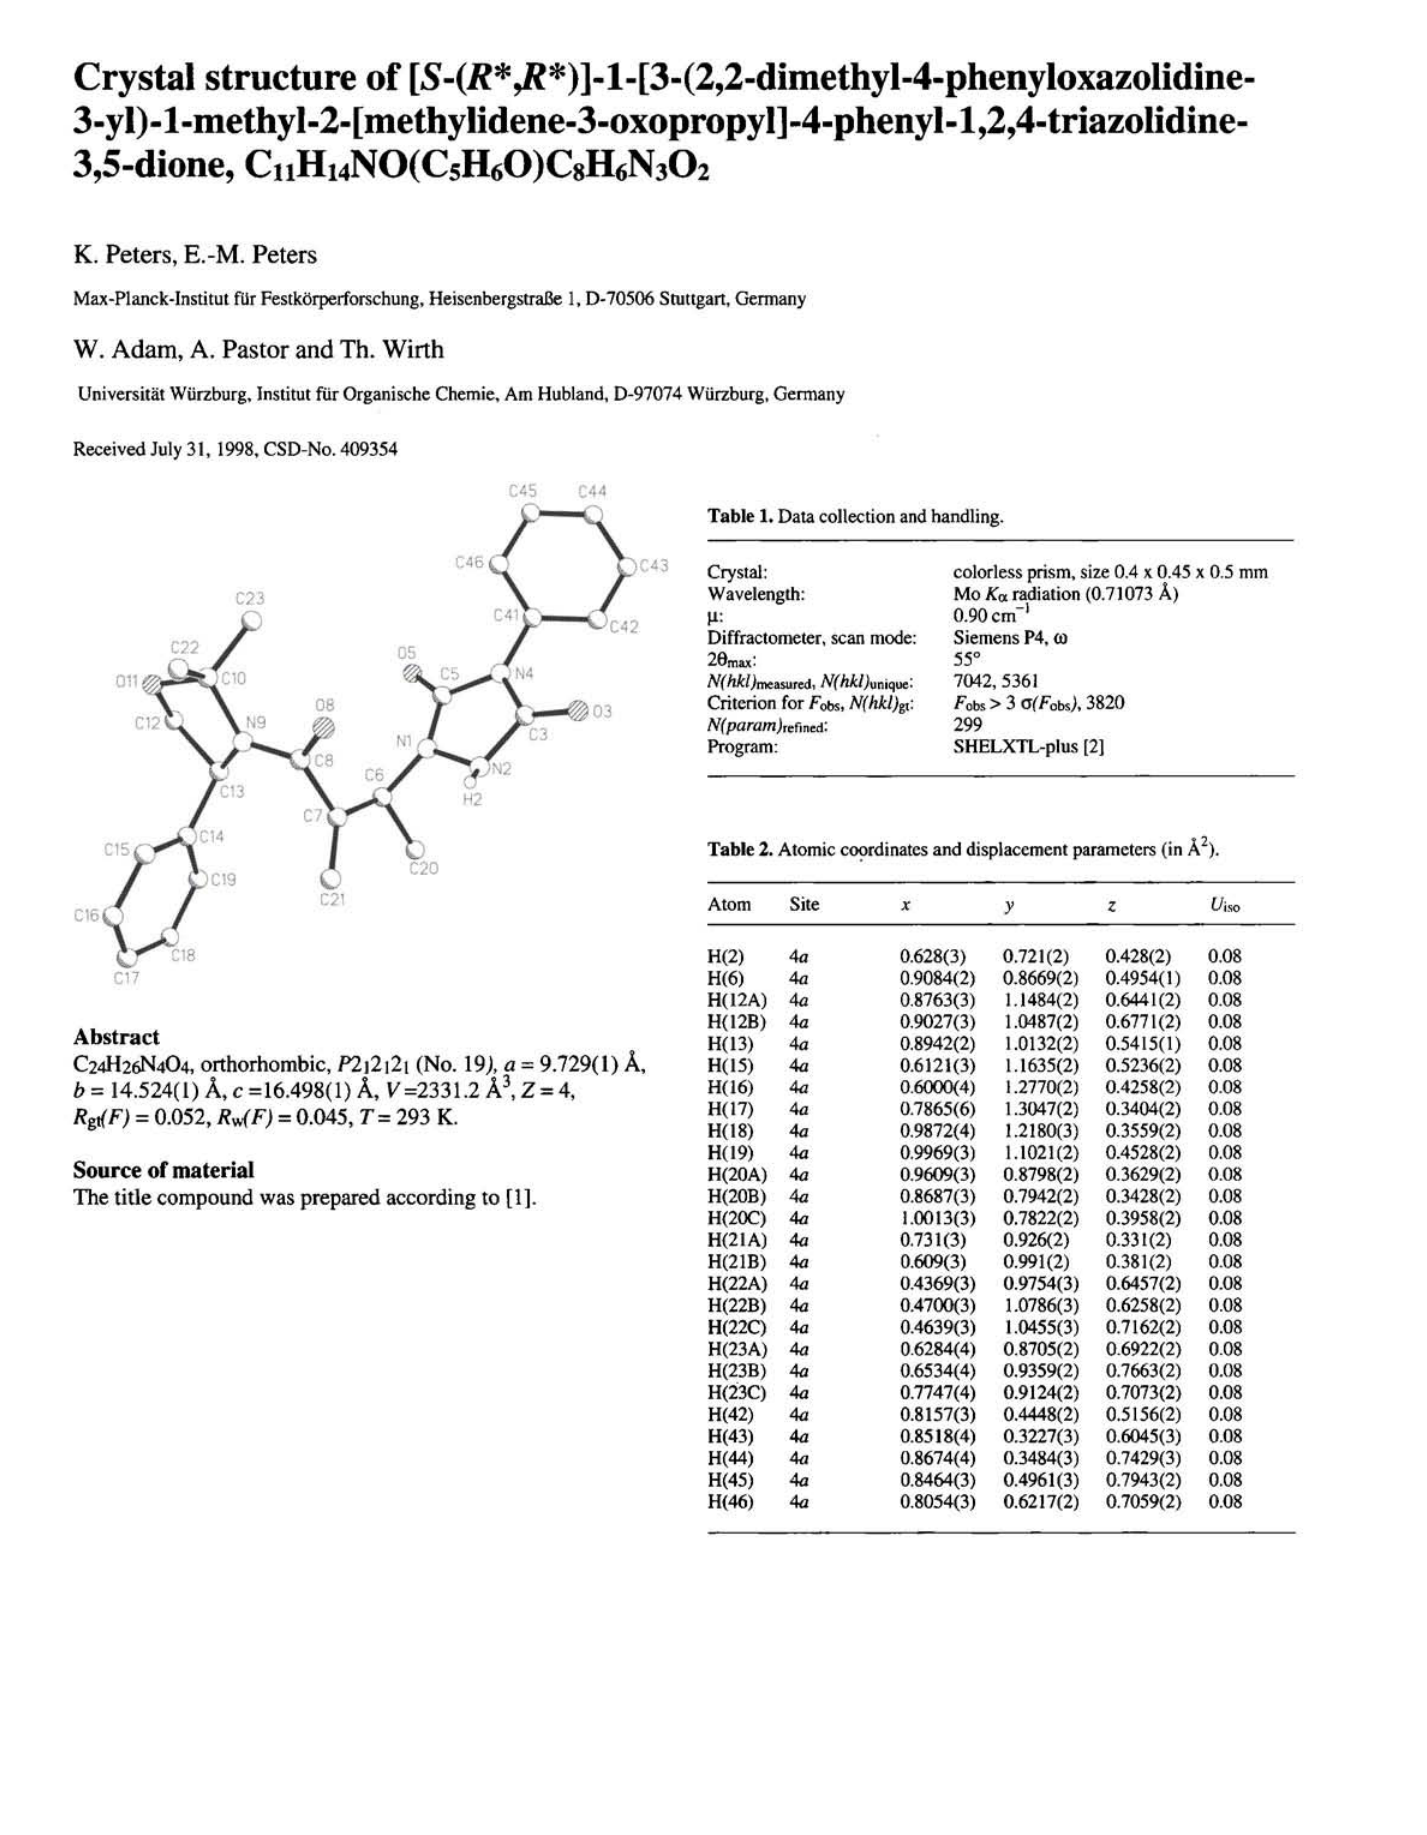
Table 2. Atomic coordinates and displacement parameters (in À 2